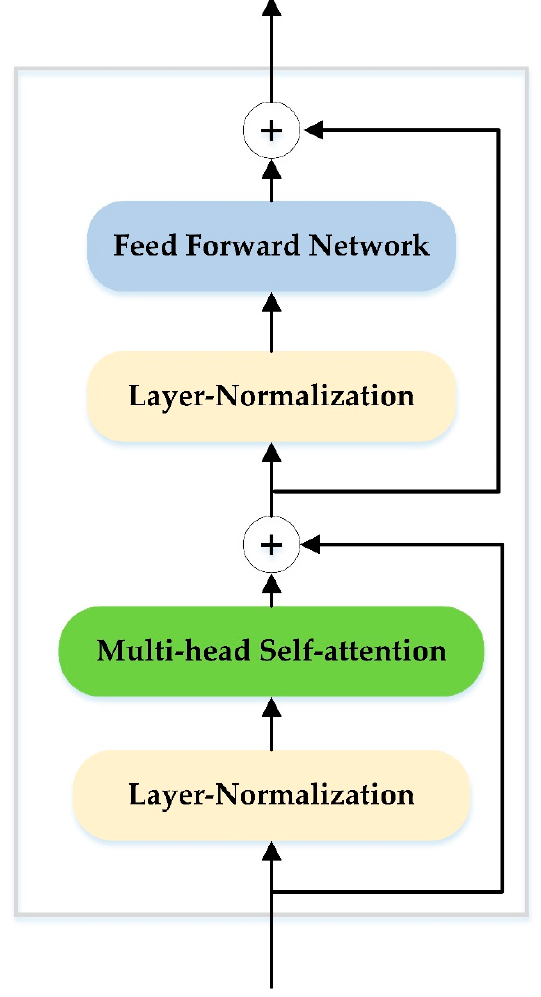
Figure 4. The structure of transformer encoder.